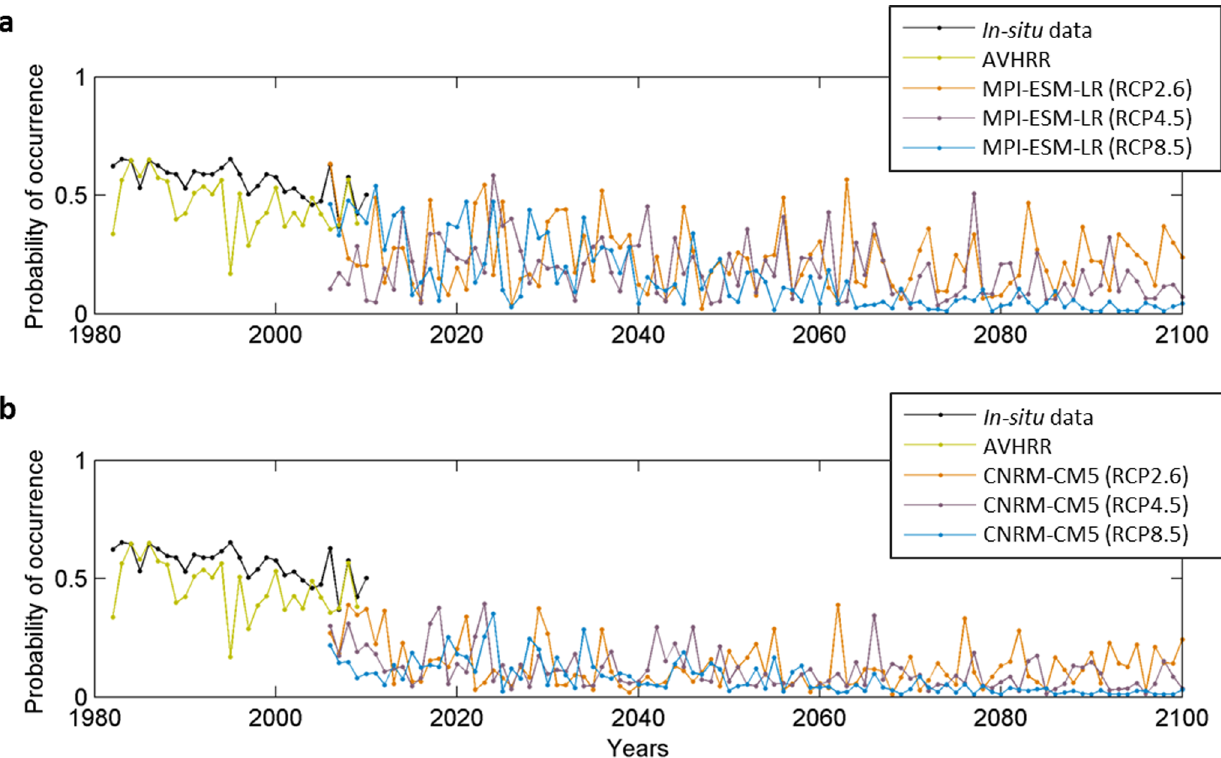
Figure 4. Observed and projected long-term changes in the probability of occurrence of Laminariadigitata in Roscoff, calculated from maximum SST at the site ‘‘Astan’’ (Brittany, France - 48 6 46 9 40 N, 3 6 56 9 15 W). Probabilities are based on maximum Sea Surface Temperature datasets (AVHRR, in-situ measurements and RCP scenarios using both CNRM-CM5 and MPI-ESM-LR models), a fixed bathymetry (5 m) and salinity (35.3). a, MPI-ESM-LR model and b, CNRM-CM5 model.